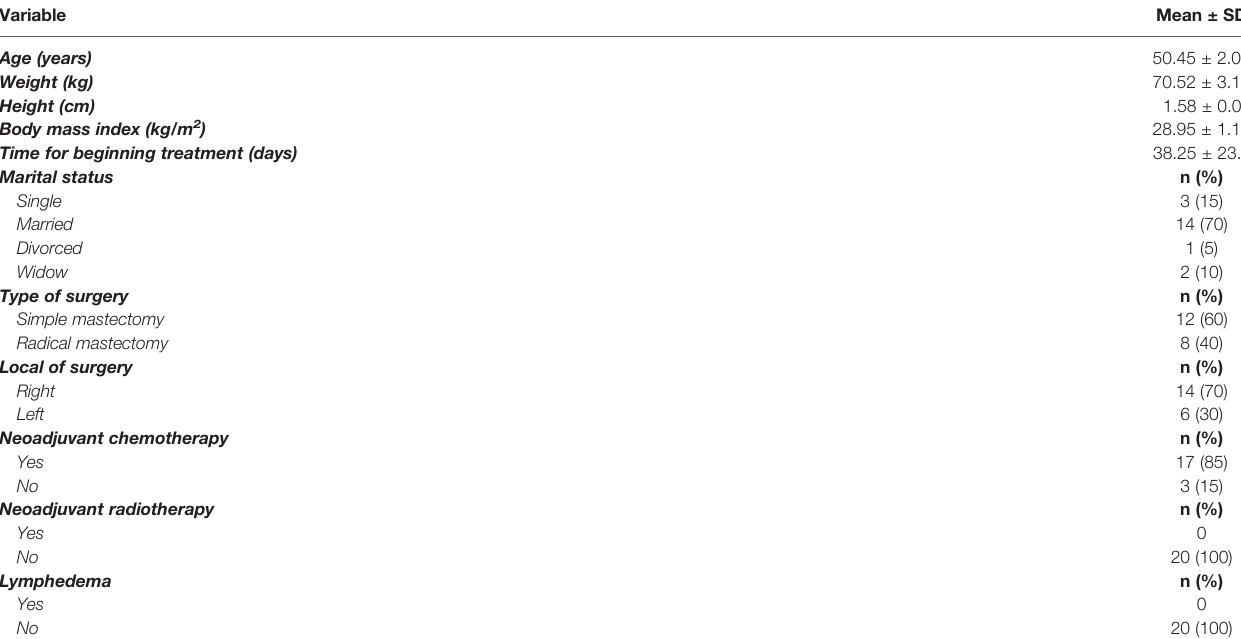
TABLE 1 | Sociodemographic, clinical, and surgical data of treated patients (n = 20). .